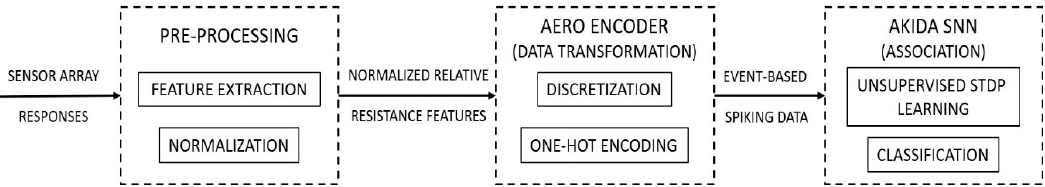
Figure 1. Block diagram of the proposed model using Akida spiking neural network (SNN) .